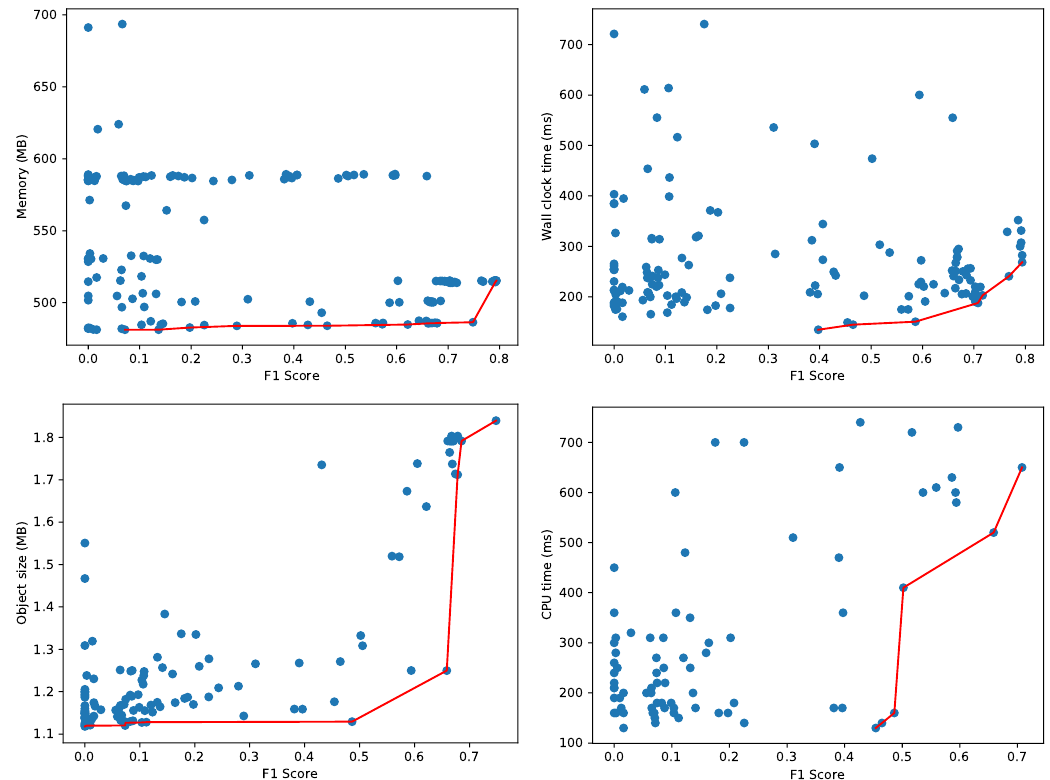
Figure 8. Pareto fronts for memory ( top left ), wall clock time ( top right ), object size ( bottom left ) and CPU time ( bottom right ) for the Yahoo! Webscope S5